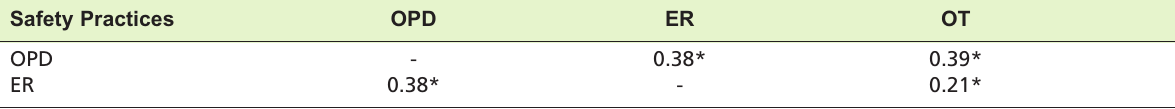
Spearman rank correlation coefficient for comparison between safety practices in three areas of practices Table III: Safety